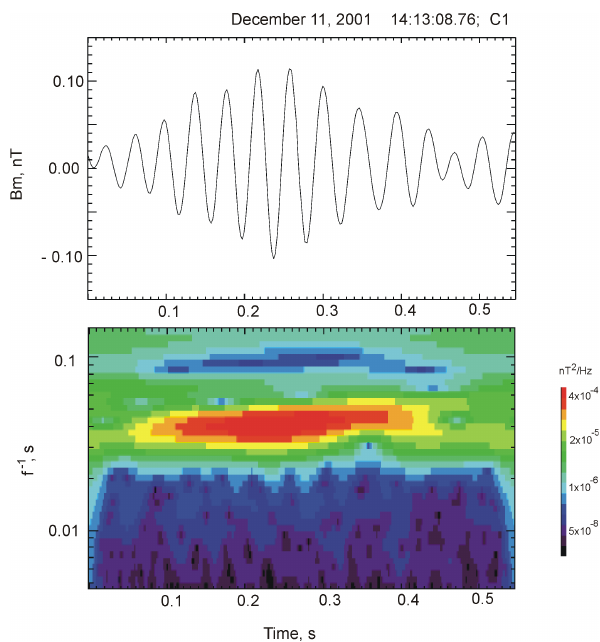
Fig. 7. The wave form of the magnetic field variations (the B m component) in a single wave packet. The bottom panel shows the wavelet spectrogram of the observed